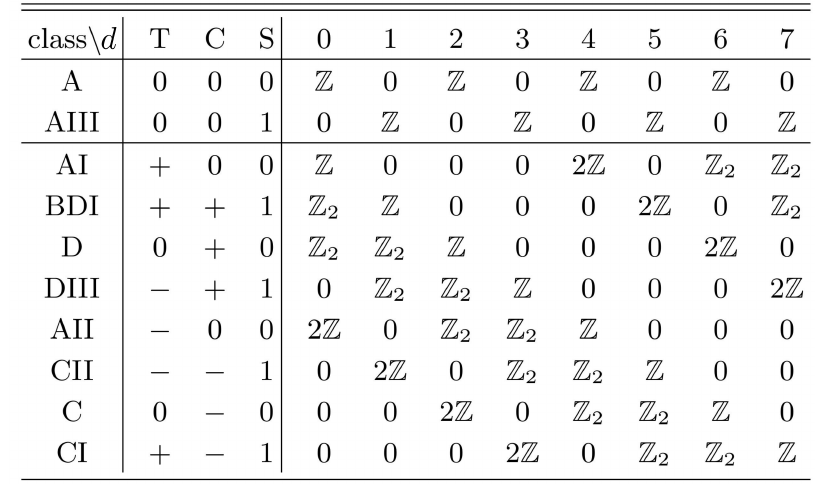
Figure 18: The tenfold classification of symmetry protected topological phases of non-interacting fermions. See the text for explanation of axis labels and